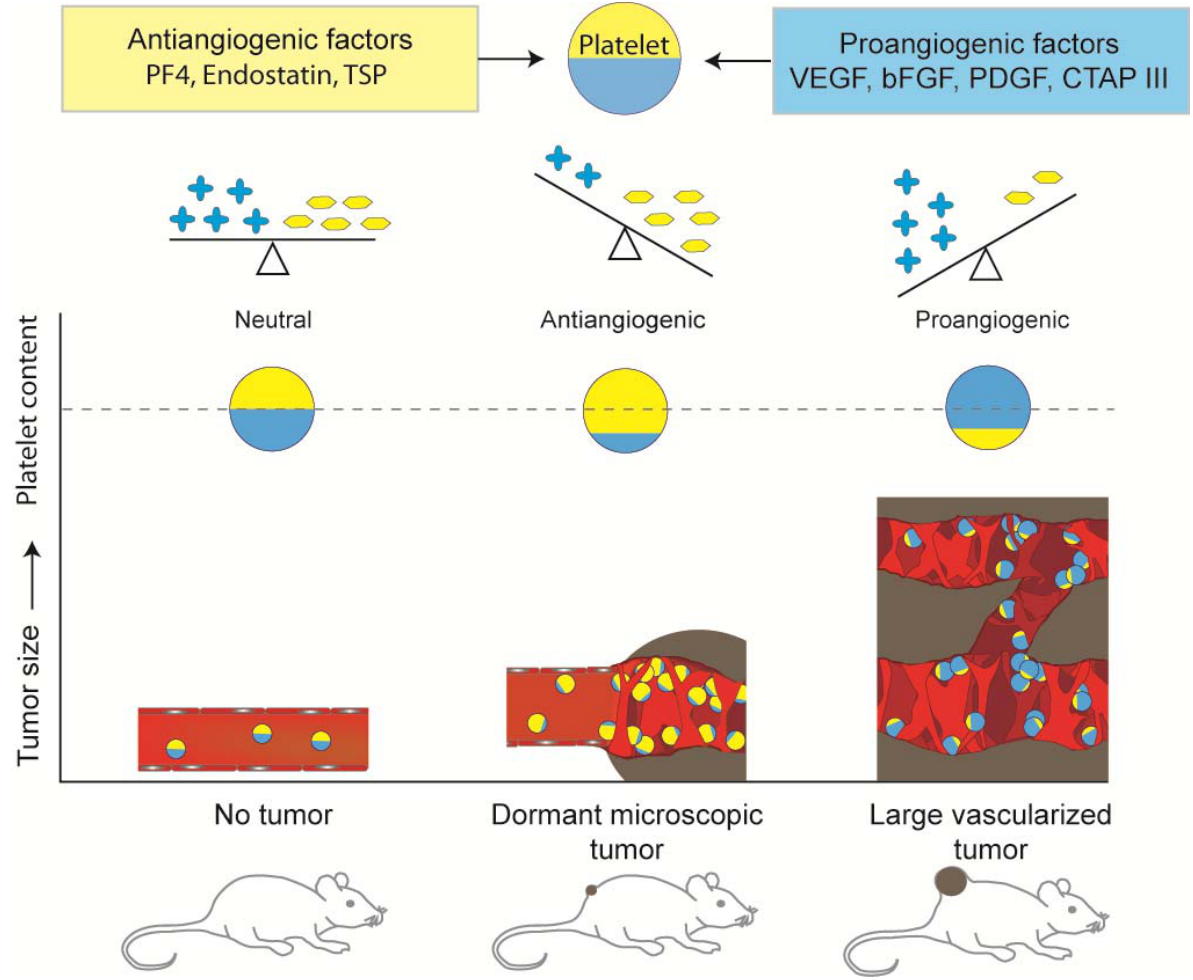
Figure 1. Schematic presentation of changes in the balance of angiogenic factors in circulating platelets, which reflect the presence of tumors. Presence of even a microscopic dormant tumor can induce an increase in level of antiangiogenic factors in platelets, while presence of large, fast growing and angiogenic tumor results in an increase of angiogenic factors [4,5]. It should be recognized that this overall decrease or increase in the respective angiogenesis phenotype represent a change in the overall angiogenic function and that platelets of dormant tumor bearing mice may have a significant amount of pro-angiogenic proteins that are balanced by sufficient numbers of